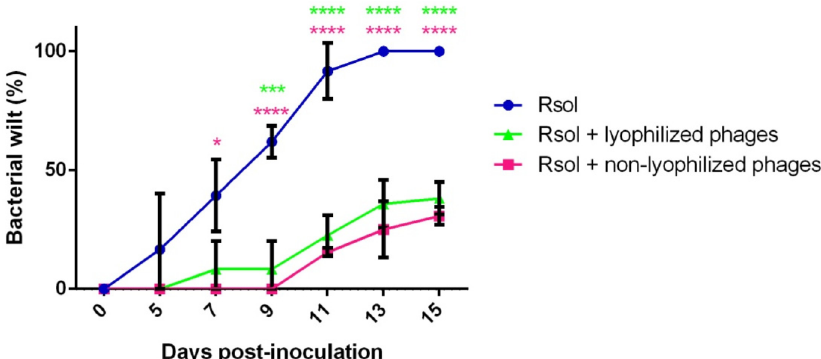
Figure 6. Bacterial wilt biocontrol assays in planta inoculated with Ralstonia solanacearum strain CFBP 4944 and a mixture of the phages vRsoP-WF2, vRsoP-WM2 and vRsoP-WR2 either nonlyophilized or lyophilized after 4 weeks. Mixtures were co-inoculated at final concentrations bacterium:phages of 10 5 CFU/mL:10 8 PFU/mL. Positive controls (Rsol) were at 10 5 CFU/mL. Negative controls (mixtures of phages) were at 10 8 PFU/mL. Additional negative controls were performed with PBS. Plants inoculated with negative controls, either mixtures of phages or PBS, did not develop wilting symptoms (not shown). Data are the means for assays performed in triplicate, and error bars indicate variation as the standard deviation. Asterisks denote statistically significant differences between the treatments: * p < 0.05, *** p < 0.001, **** p <